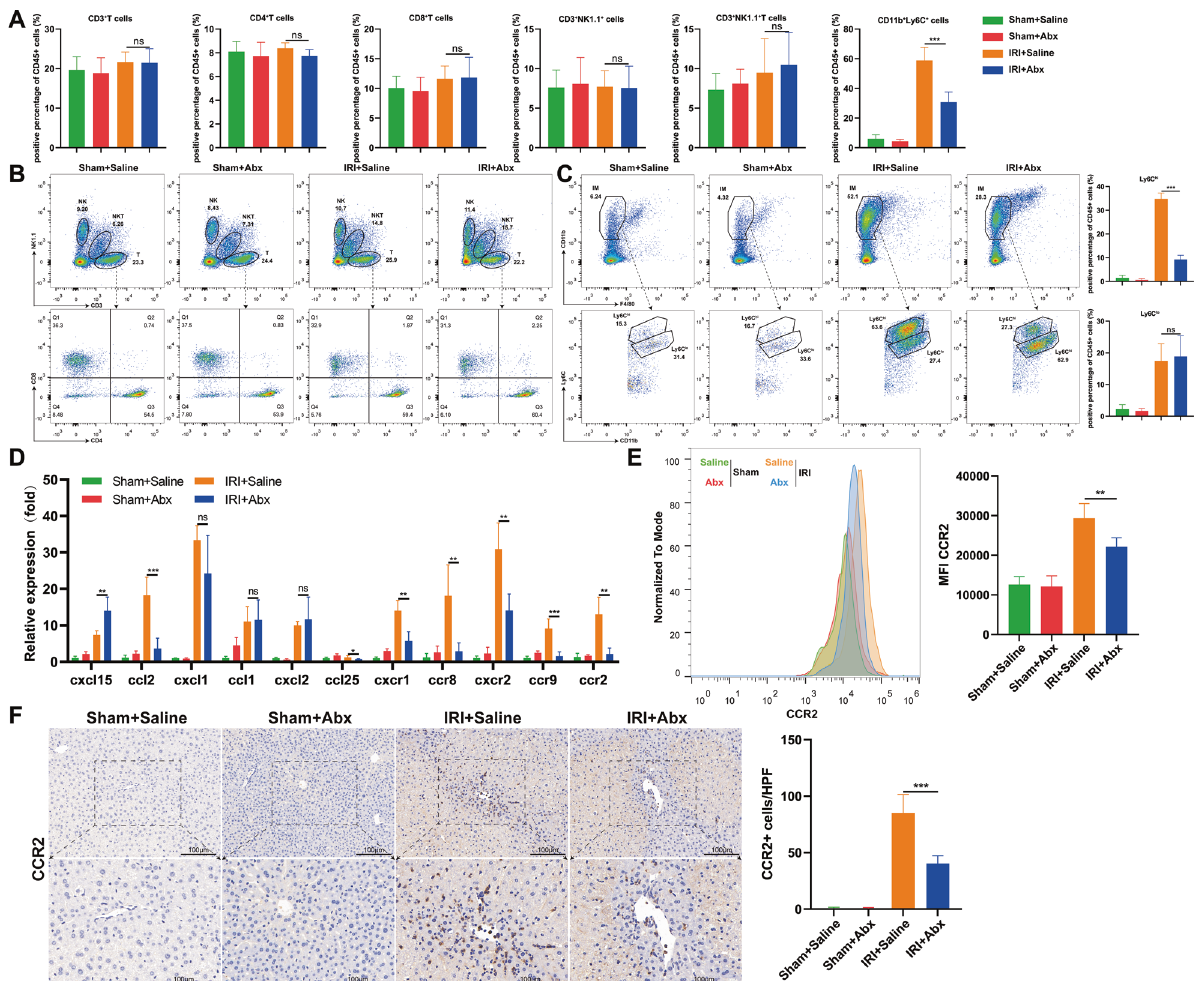
different NPC cell proportions in the liver after sham and IRI modeling and quantitative histogram of two subsets of IMs (Ly6C hi and Ly6C lo ). D The expression of chemokines and corresponding receptors at the mRNA level in liver tissues after sham and IRI modeling in each group. E Average fl uorescence intensity of CCR2 + monocytes in each group (gated on CD45 + CD11b + cells). F Representative images of CCR2 + monocytes in liver sections ( n = 5 per group). Scale bars, 100 μ m. Data are the mean ± SEM, ∗ p < 0.05; ∗∗ p < 0.01; ∗∗∗ p < 0.001 by unpaired Student ’ s t